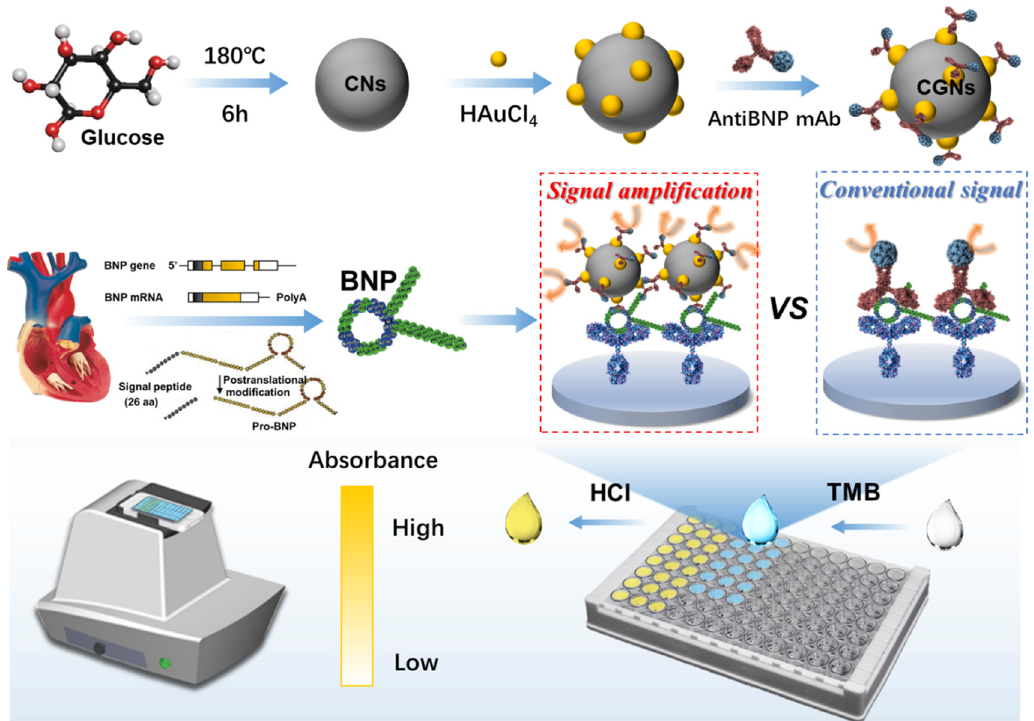
Figure 1. Schematic illustration of the multifunctional immunocolorimetric sensing system for sensitive detection of BNP with CGNs amplification. By immobilizing AuNPs, CGNs were successfully synthesized through hydrothermal method. Then CGNs@AntiBNP-HRP was fabricated as the carrier, signal amplifier, and detector for the sensitive detection of BNP. Combing with the portable bionic e-Eye, the sensing system could identify BNP with significantly enhanced sensitivity through the color change of antibody-antigen reactions.